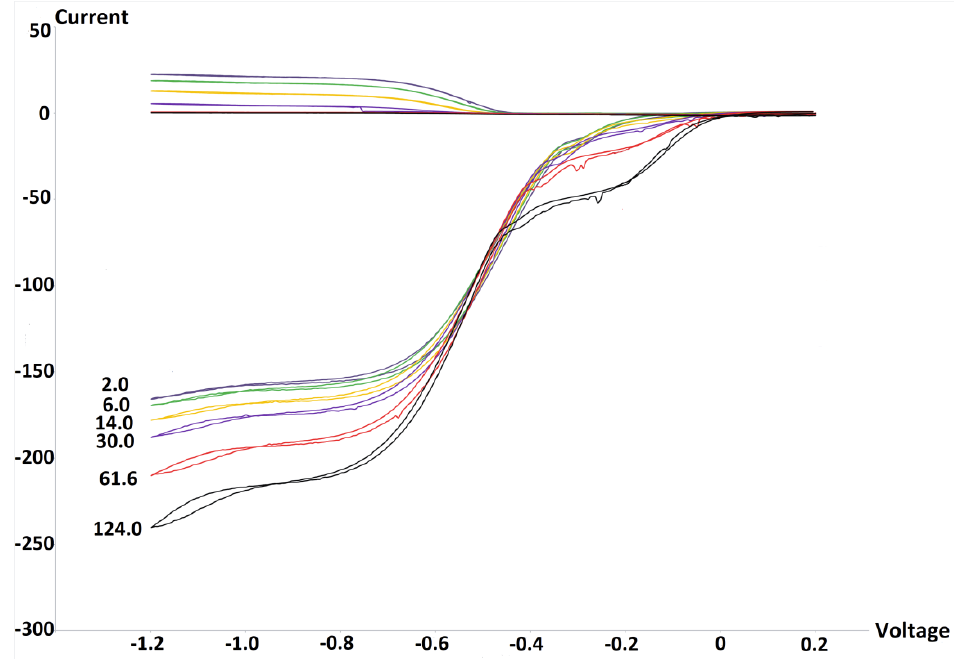
Figure 1. Rotating ring-disk electrode (RRDE) graph of embelin. Each run has a specific color, for instance, the yellow color is associated with 14.0 × 10 −5 M concentration, and is consistently shown above, at the ring electrode. The bulge centered at −0.2 volts is probably due to capture of an electron by embelin, as demonstrated recently by the quinone emodin [22], and so the whole effect is due to sequestering superoxide plus embelin reduction.